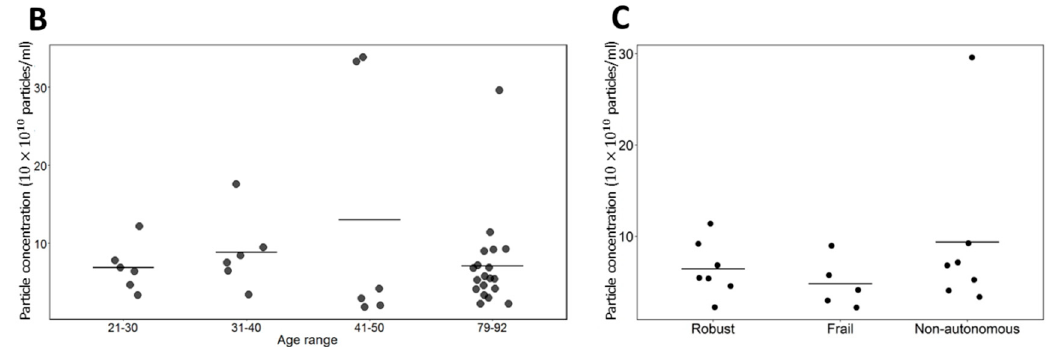
Figure 2. Nanoparticle tracking analysis (NTA) of extracellular vesicles (EVs). Particle size and EV concentration were measured by NTA. ( A ) Size distribution of EVs. Each line represents one sample. Despite the particle concentration difference, all samples have a similar size distribution—they are enriched in small EVs (50–300 nm); ( B ) EV concentration of different age ranges were compared and samples from elder people (79–92 years) do not show an increased EV number; and ( C ) among elder individuals, the frailty status does also not alter EV concentration. In figures ( B ) and ( C ) each dot shows the EV concentration of a subject and the line represents the average value of the group.